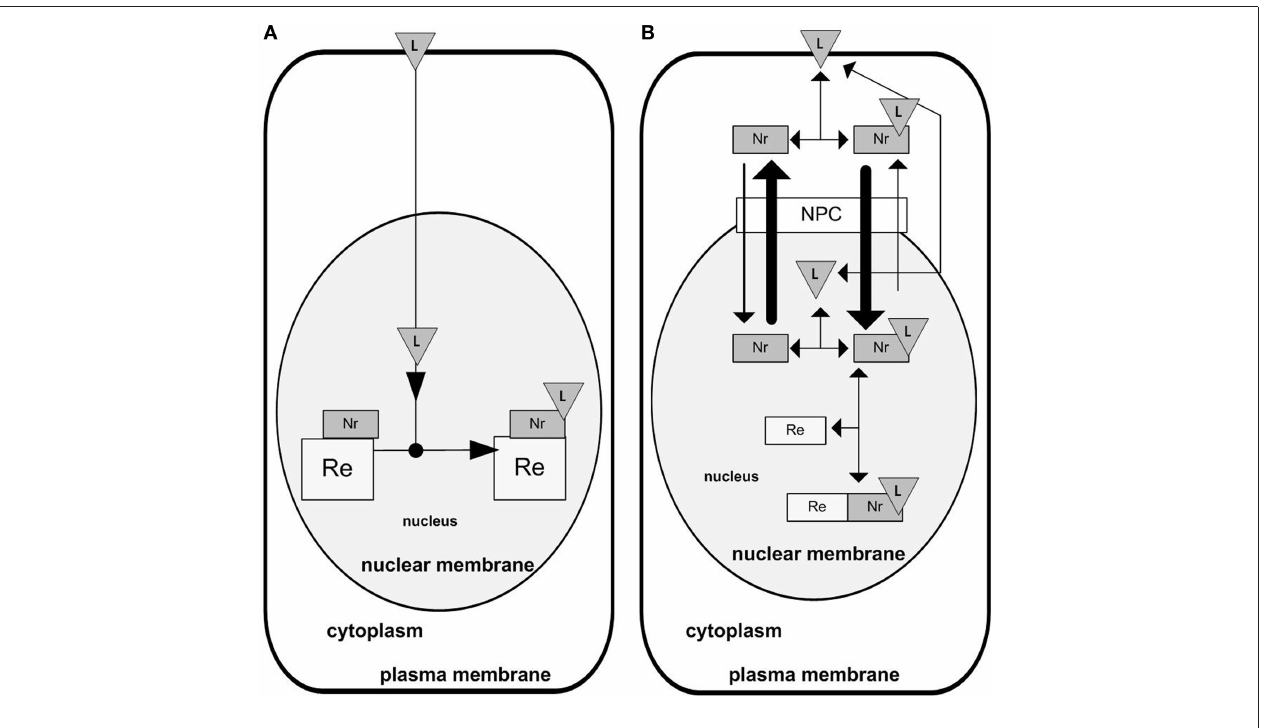
FIGURE 2 | Designs of NR signaling. (A) Classical design. The NR is attached to its response element on the DNA and waits for a ligand freely diffusing to the nucleus. Upon ligand binding the NR participates in chromatin remodeling regulating the availability of genes for